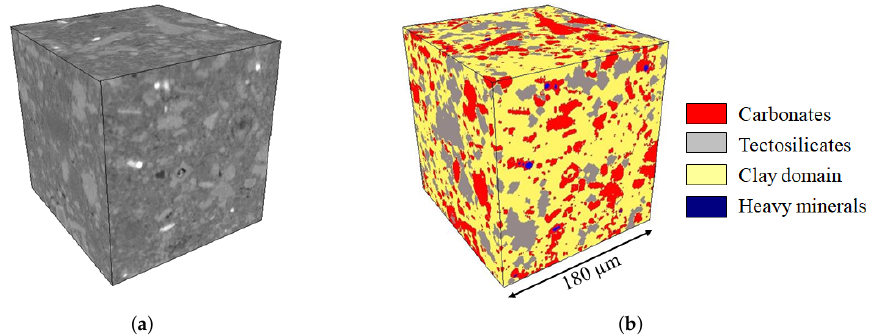
Figure 4. ( a ) 3D image by synchrotron X-ray micro-tomography (with a spatial resolution of 0.7 × 0.7 × 0.7 µ m 3 / pixel); ( b ) 3D distribution of a simplified mineralogy [7,45].